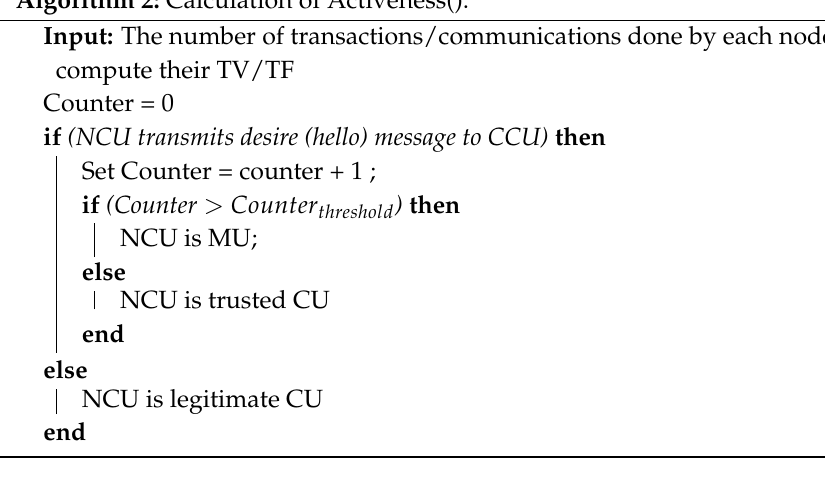
Algorithm 3: Calculation of